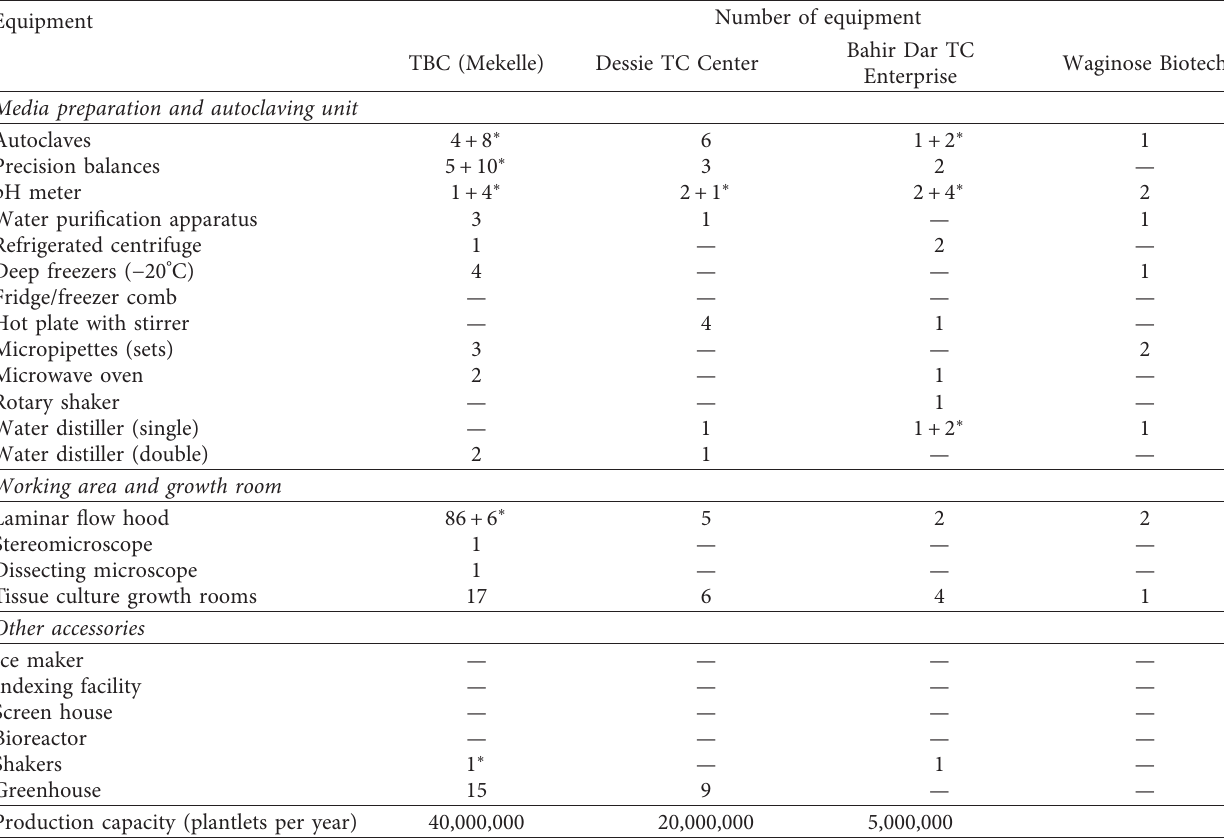
Table 3: List of basic laboratories equipment available in commercial TC laboratories.